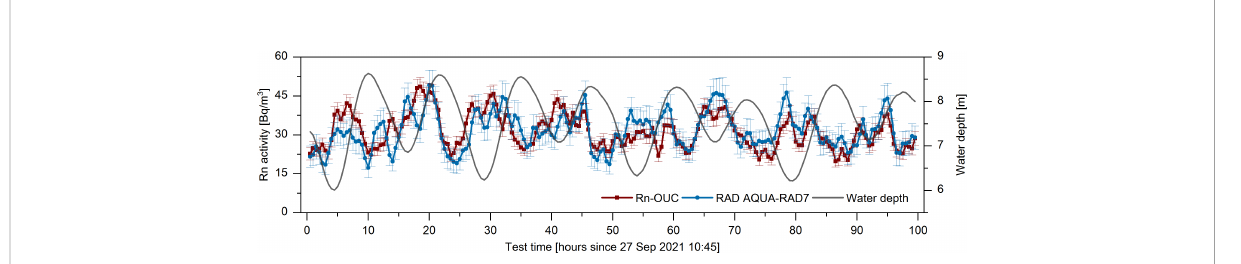
FIGURE 5 A 5-day time-series radon measurement conducted beneath (2.5 m) a fi xed fl oating platform in the Jiaozhou Bay from 27 September to 2 October 2021. The water depths (black line) were measured by a portable CTD-diver using 10-min intervals. The red lines were determined by the OUC-Rn system, while blue lines represent results from the RAD AQUA-RAD7 system. The error bars represent the 2- s uncertainties based on counting